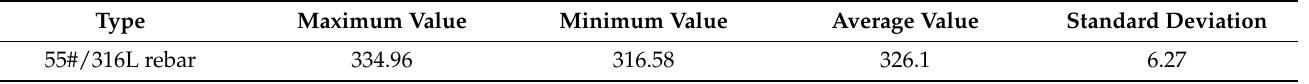
Table 7. Test results for the bonding strength (wt.